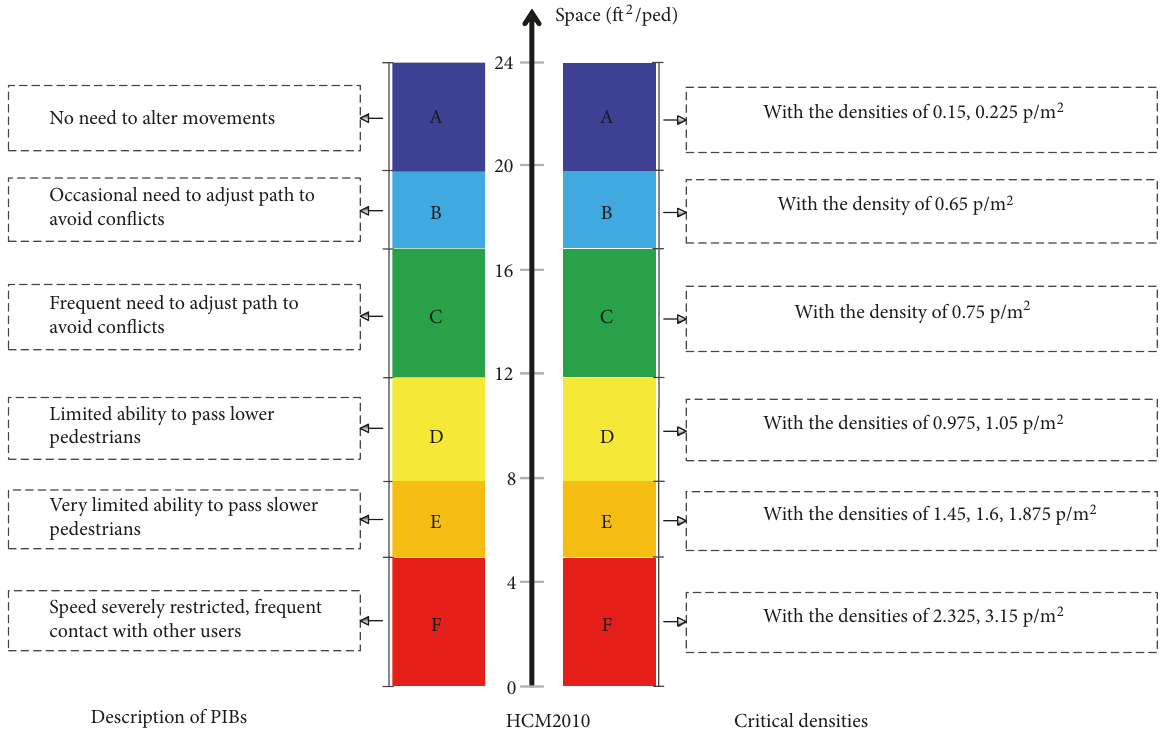
Figure 15: Descriptions of PIBs in HCM 2010 and critical densities identified in this